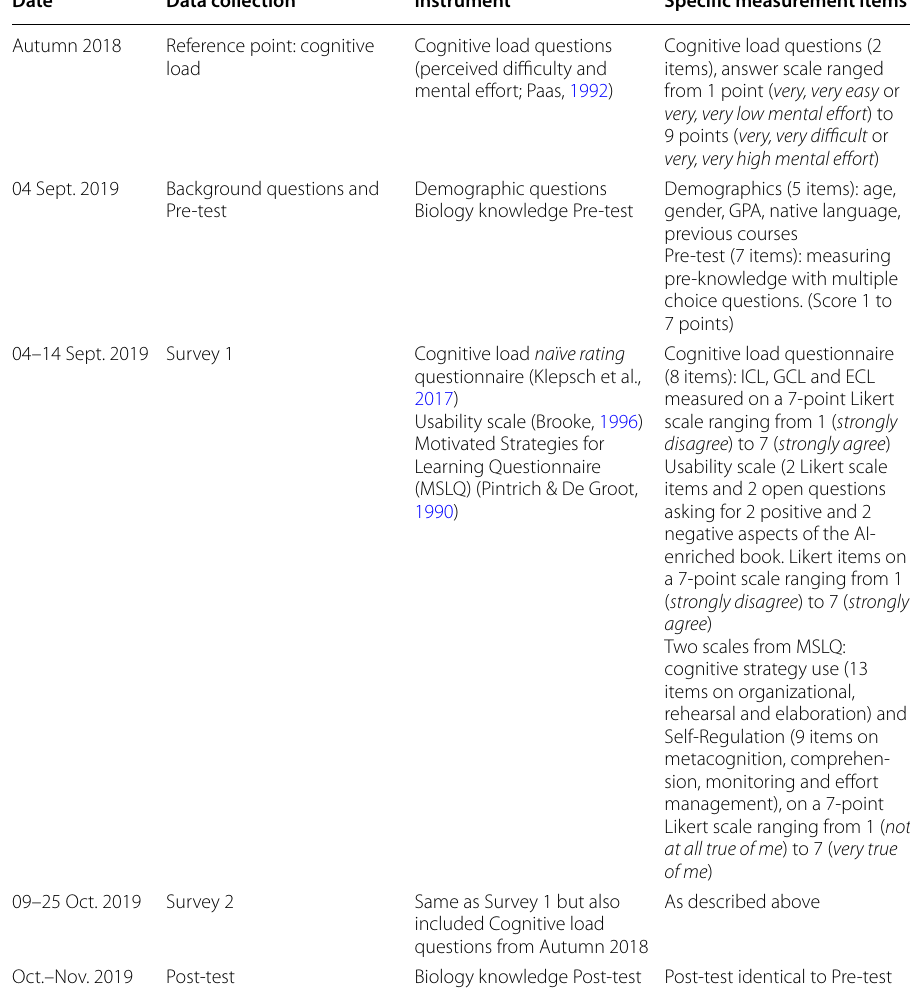
Table 1 Data collection dates and accompanying instruments and